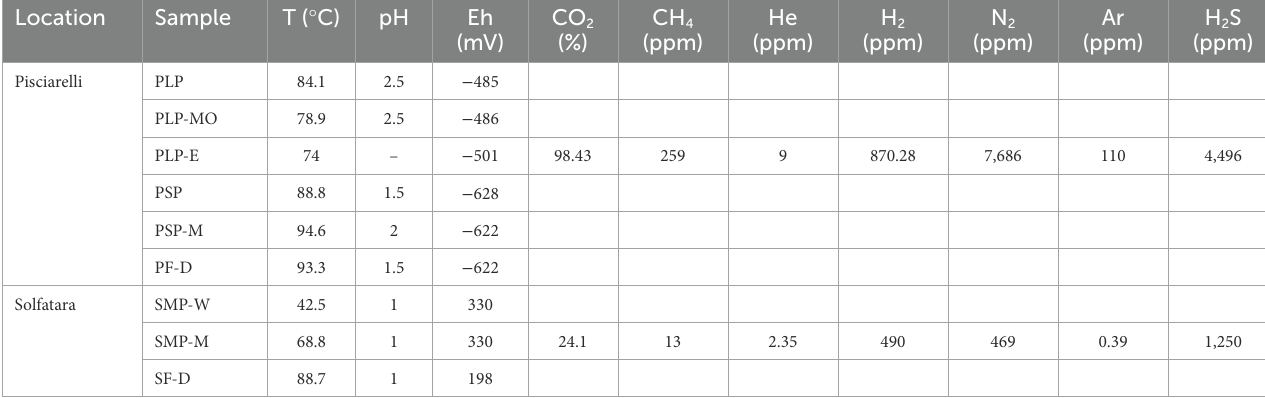
TABLE 1 Field measurements for water (W), mud (M), mud outlet (MO), epilith from dry mud wall (E), and fumarolic deposits (D) samples collected from Solfatara-Pisciarelli hydrothermal systems. Location